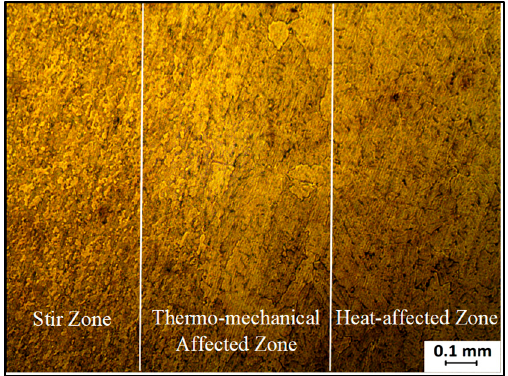
Figure 8. Microstructure of stir zone, thermo-mechanical affected zone, and heat-affected zone (5×) of FSPed recycled AA 6063/TiO 2 surface composites.